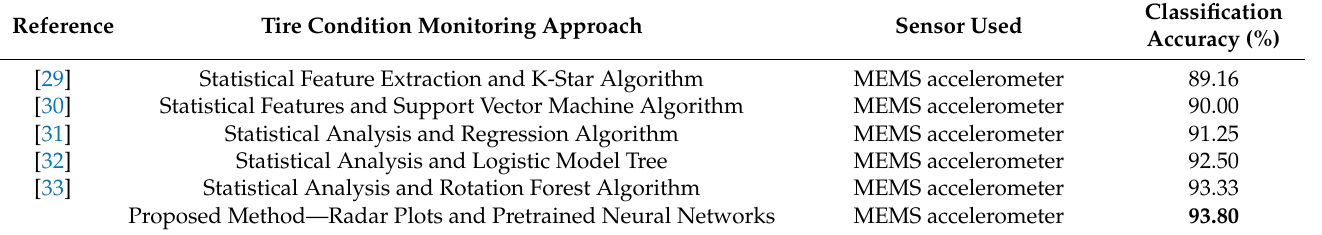
Table 9. Comparison of tire condition monitoring approaches with our proposed method.